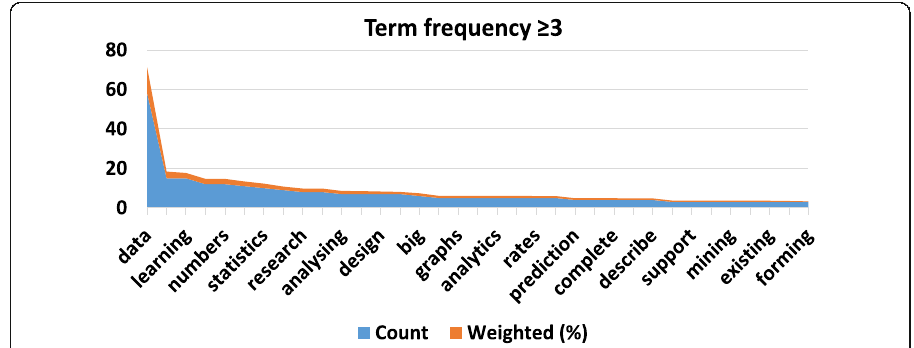
Fig. 1 Summary of analytics term